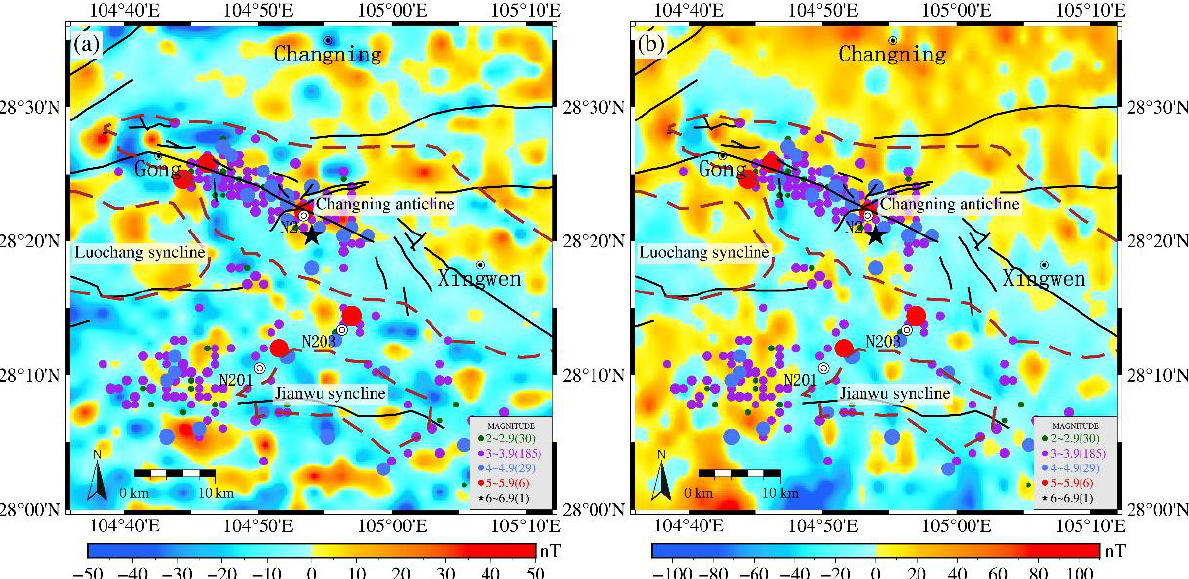
Figure 4. Distribution characteristics of earthquakes in the Changning area; ( a ) shows the contour map of the magnetic anomalies, while ( b ) shows the same contour map after RTP. Different colors represent different earthquake magnitudes. The earthquake catalog is from March 2012 to March 2022.